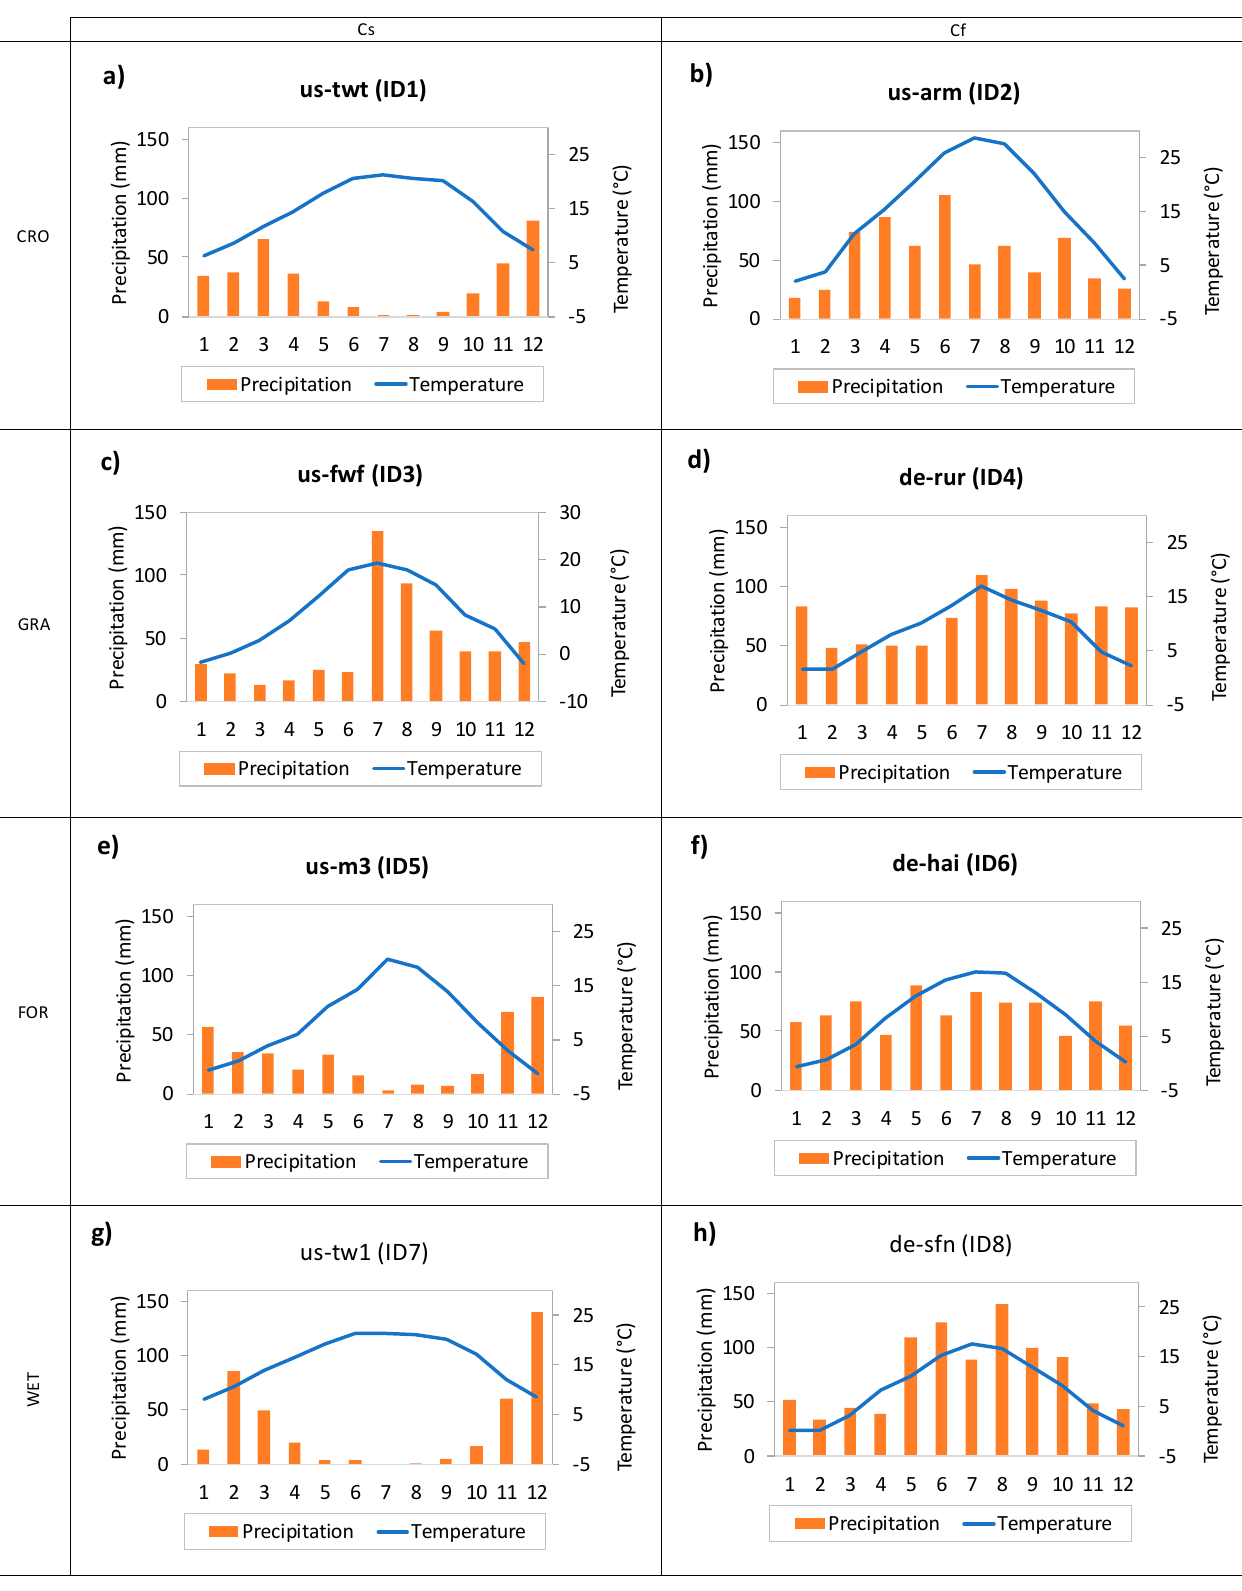
Figure 2. Temporal patterns of the monthly average precipitation and air temperature for the eight selected sites: ( a ) us-twt, ( b ) us-arm, ( c ) us-fwf, ( d ) de-rur, ( e ) us-me3, ( f ) de-hai, ( g ) us-tw1, ( h ) de-sfn.